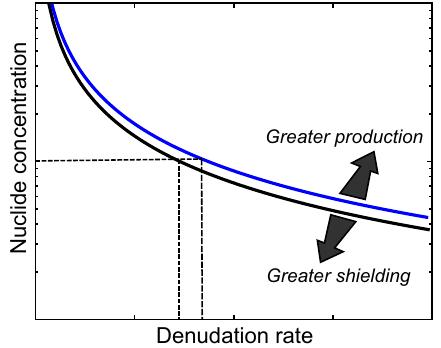
Figure 1. A schematic drawing of the predicted concentration of a nuclide as a function of denudation rate. If production rates are as- sumed to be higher, the predicted concentration will be higher for a given denudation rate. If shielding is greater, the predicted concen- tration is lower for a predicted denudation rate. Thus assumptions about production and shielding will affect the inferred denudation rate given a sample with fixed concentration, shown with the dashed